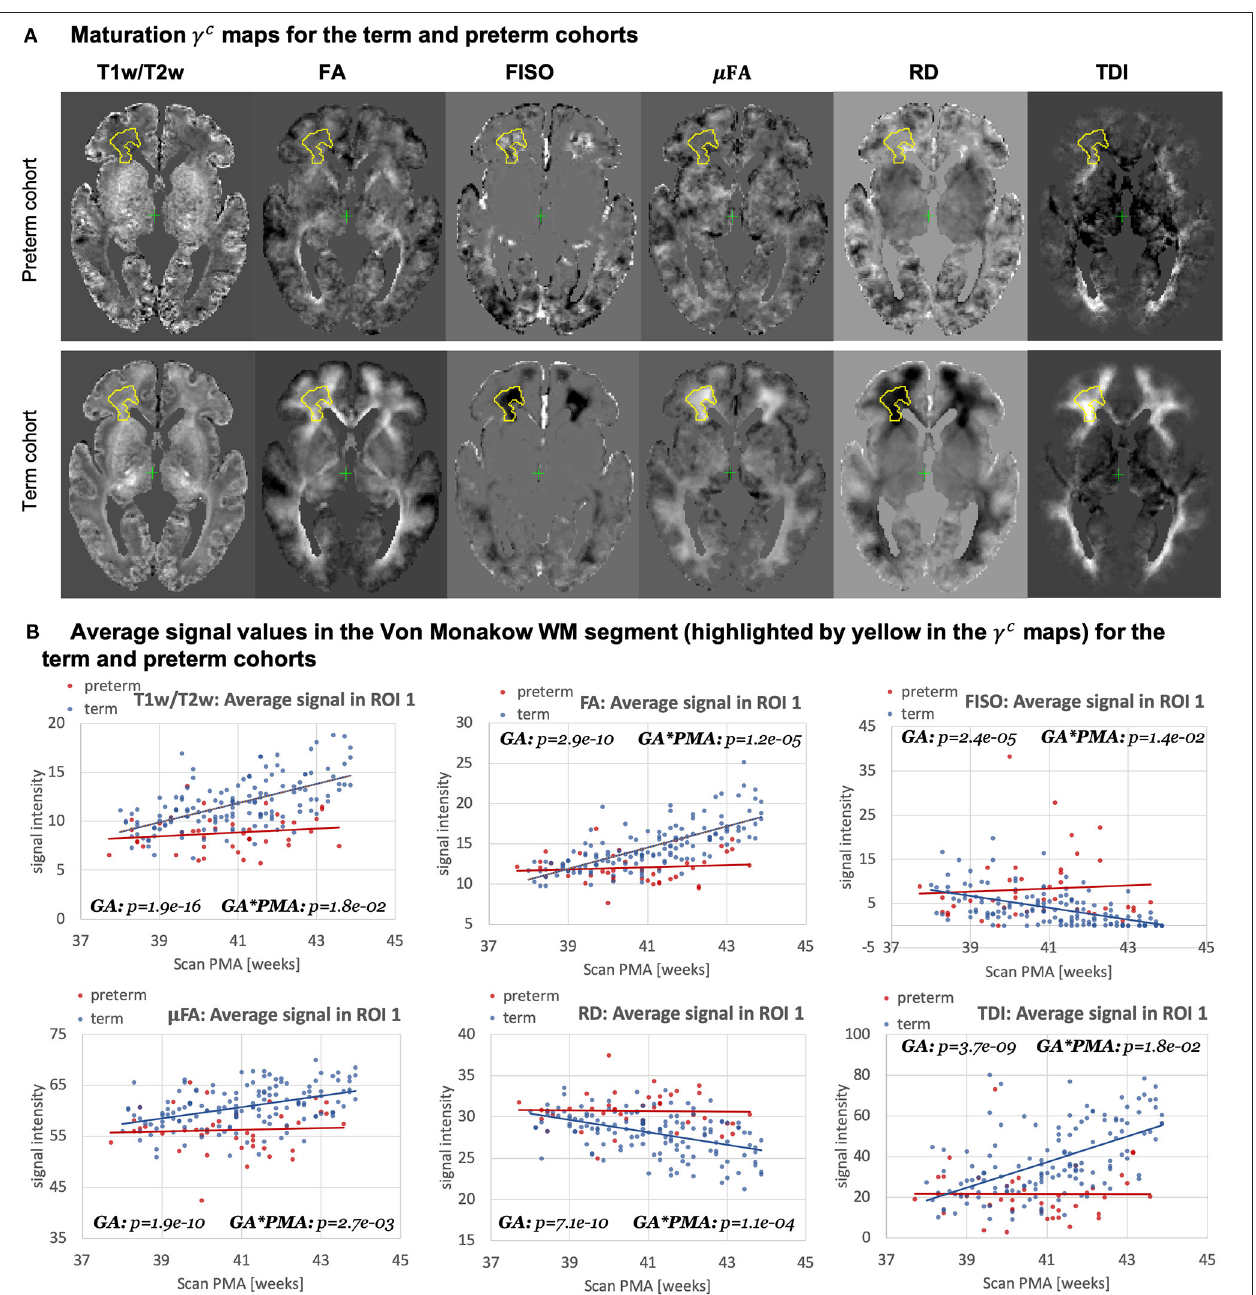
FIGURE 15 | Atlas-based analysis: comparison of the term (140) and preterm cohorts (40) for 38 to 43 weeks scan PMA range for a subset of channels c= { T1w/T2w; TDI; RD; FA; FISO; µ FA } . (A) The γ c maps of GF fitting for the term and preterm cohorts for 38 to 43 weeks PMA range. (B) The mean signal values in the frontal WM ROI from the γ average parcellation map (highlighted in yellow in the gamma maps) for the term (blue) and preterm (red) cohorts for 38–43 weeks PMA